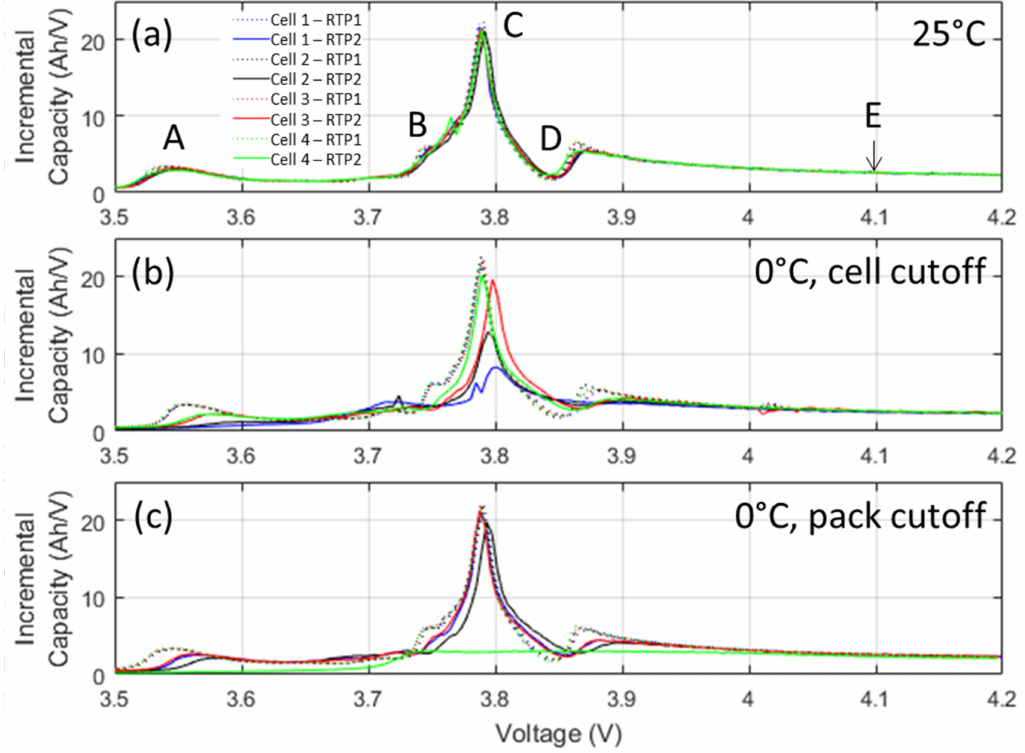
Figure 11. Incremental capacity curves for cells prior to cycling (solid lines for RPT 1) and post cycling (dashed lines for RPT 2) at ( a ) 25 ◦ C, ( b ) 0 ◦ C with cell voltage cut-off and ( c ) 0 ◦ C with pack voltage cut-off.